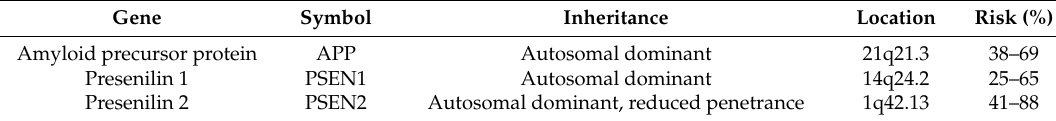
Table 2. Dominant autosomal genes regarding AD